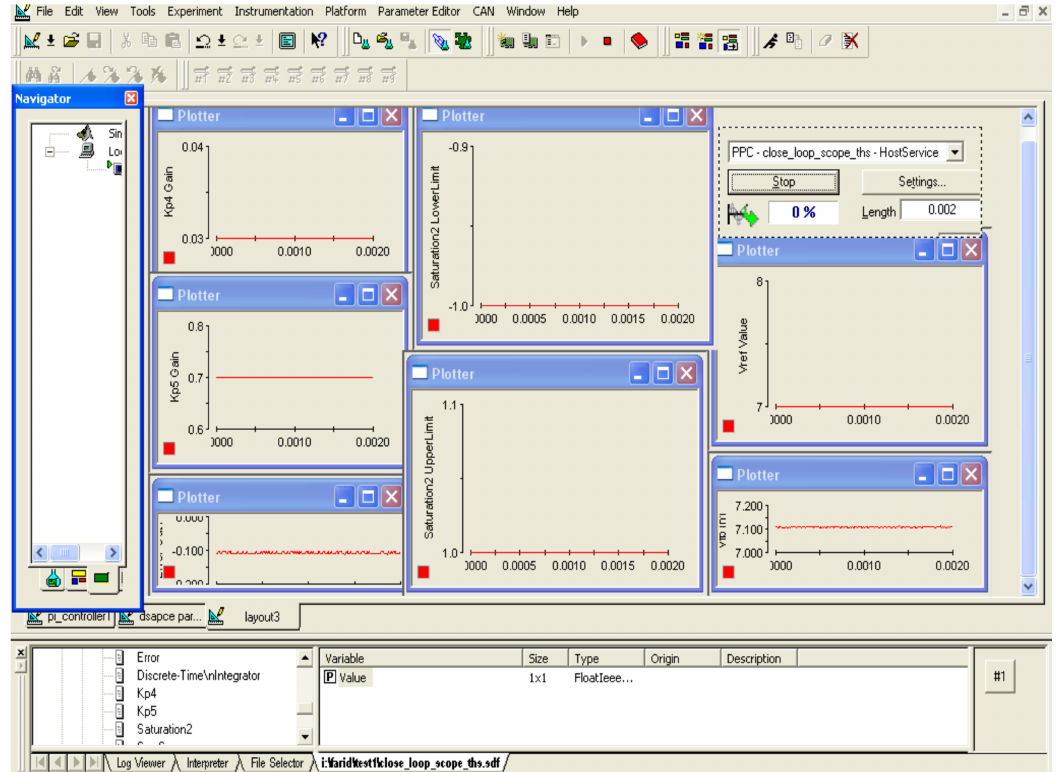
Figure 13. dSPACE GUI parameter